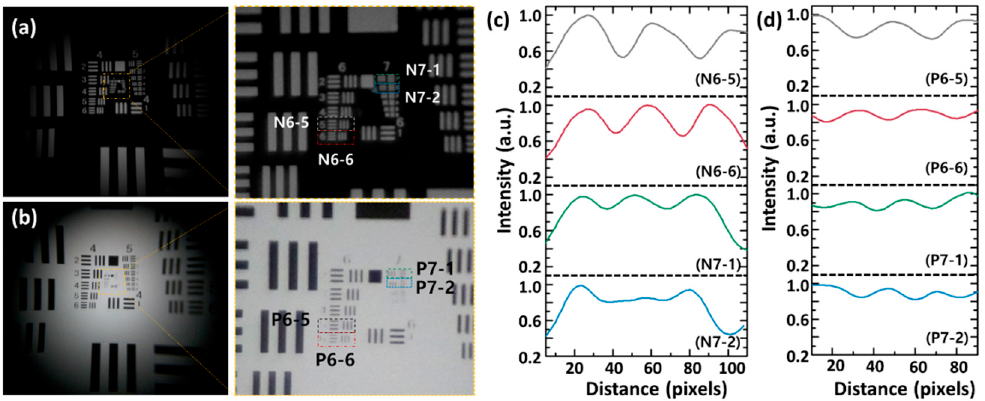
Figure 2. Imaging characterization of MCM. The captured ( a ) negative and ( b ) positive USAF 1951 resolution target images through the MCM. The central area was magnified with digital zoom. The corresponding normalized intensity profiles of captured ( c ) negative and ( d ) positive USAF 1951 target images.